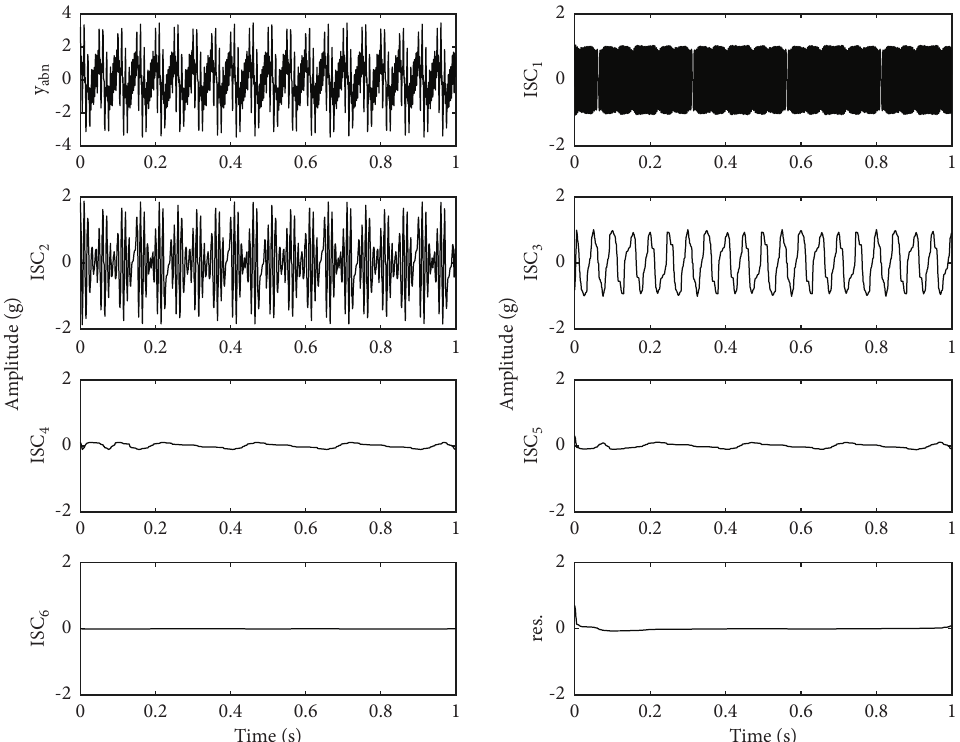
Figure 6: LCD decomposition results of y-channel under abnormal conditions.